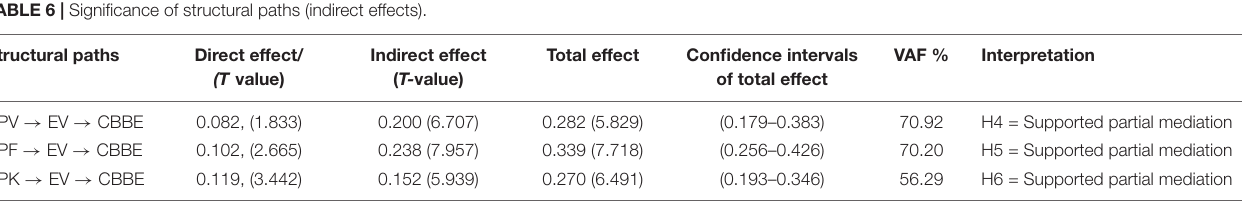
TABLE 6 | Significance of structural paths (indirect effects).